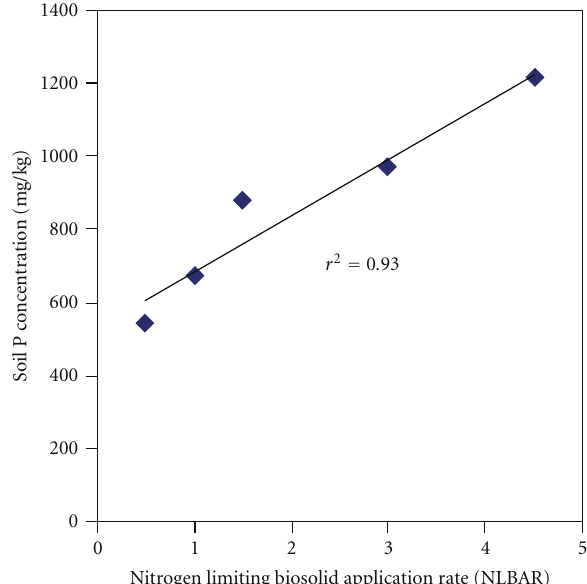
Figure 2: Mean soil total phosphorus concentrations versus biosolids application rates immediately after biosolids were applied at the Pakenham site in